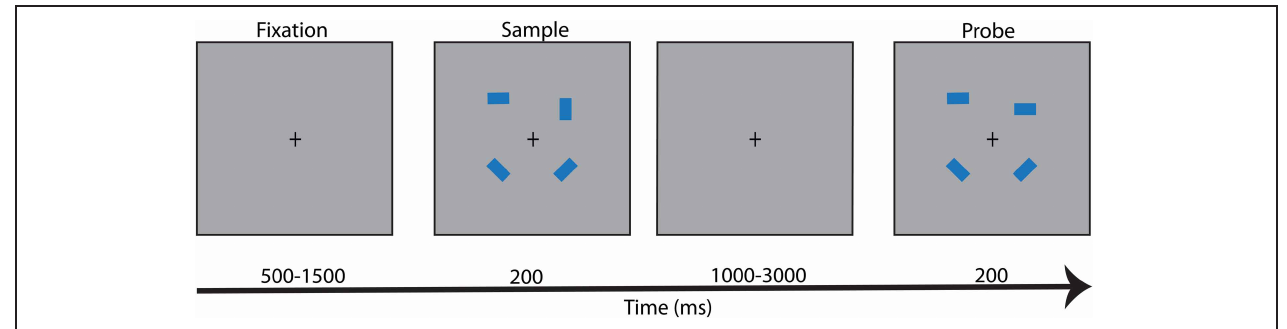
stimulus and probe matched via button-press (left/right index) after probe onset. This figure depicts a situation where the probe does not match the stimulus. On trials (50%) where the probe did not match the stimulus, one blue bar (randomly chosen) was rotated 90 ◦